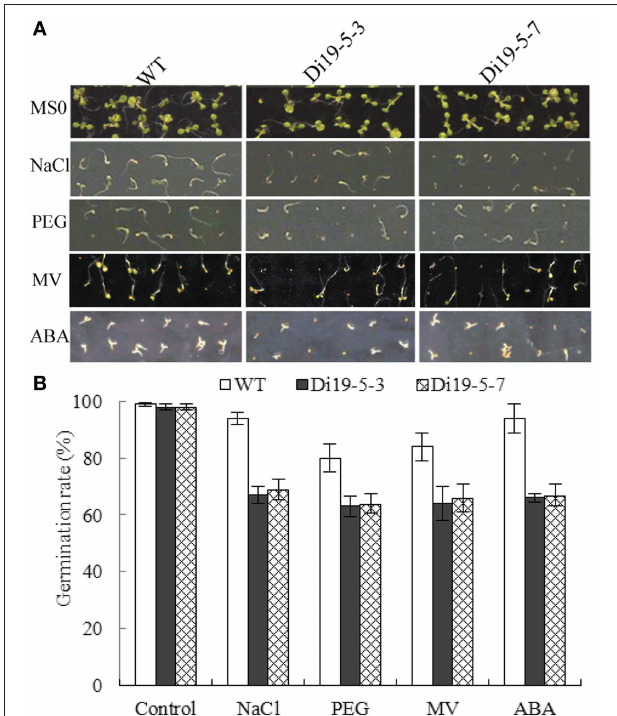
FIGURE 9 | Effect of salt, drought, oxidative and ABA stresses on seed germination of GmDi19-5 transgenic and WT seeds. (A) Germination rate of WT and transgenic seeds on MS medium with or without NaCl, PEG, MV, and ABA. (B) Statistics analysis of germination rate. Mean values and standard errors (bar) were shown from three independent